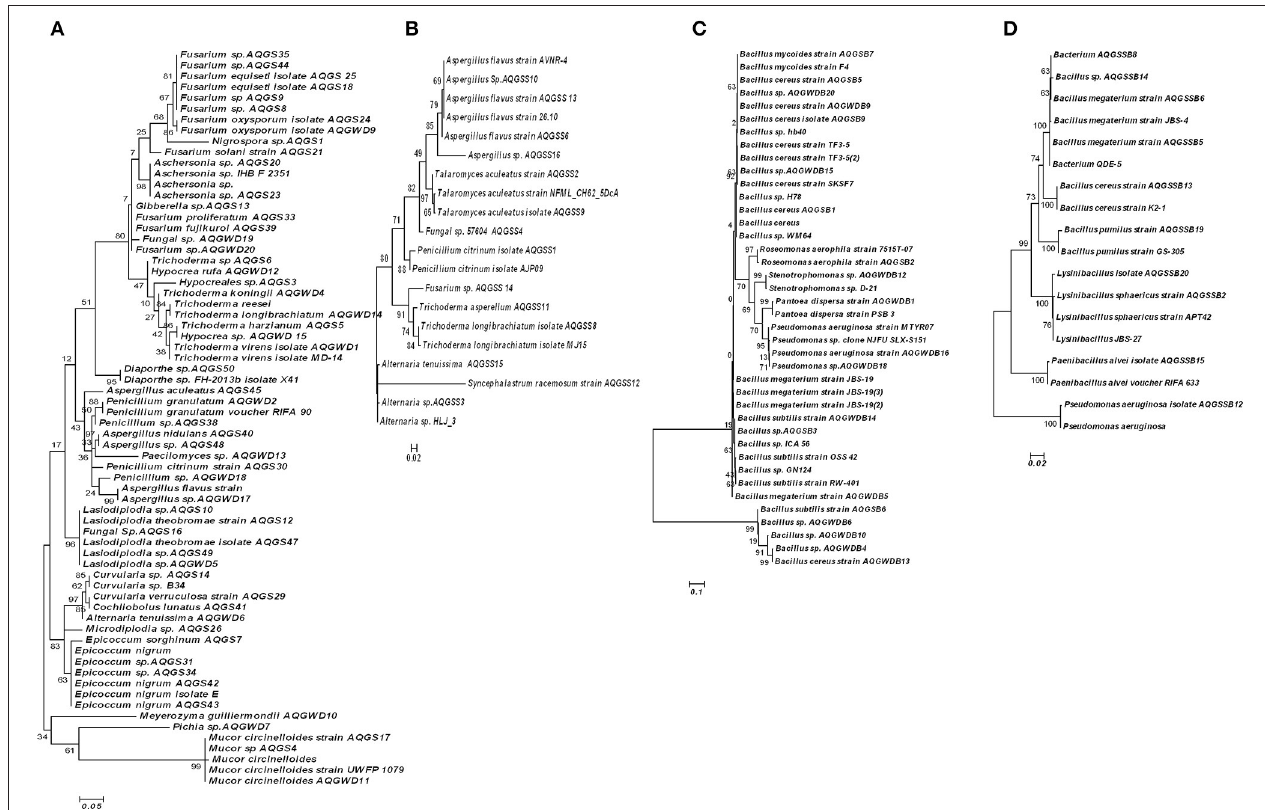
FIGURE 4 | Phylogenetic trees based on Maximum likelihood method of the SSU ribosomal sequence of different fungi from stem (A) and soil (B) and bacterial isolates from stem of Aquilaria malaccensis (C) and soil (D) .